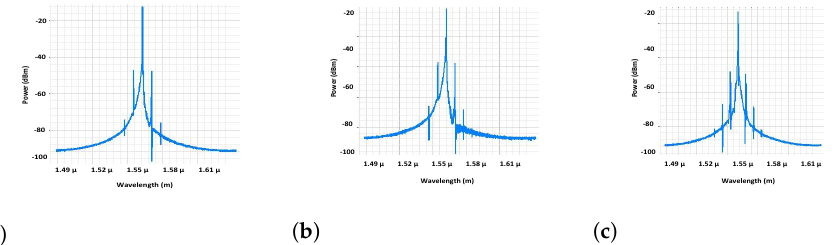
Figure 8. VCSEL spectrum analyzer. ( a ) ML-based VCSEL, ( b ) conventional model, and ( c ) simple VCSEL.